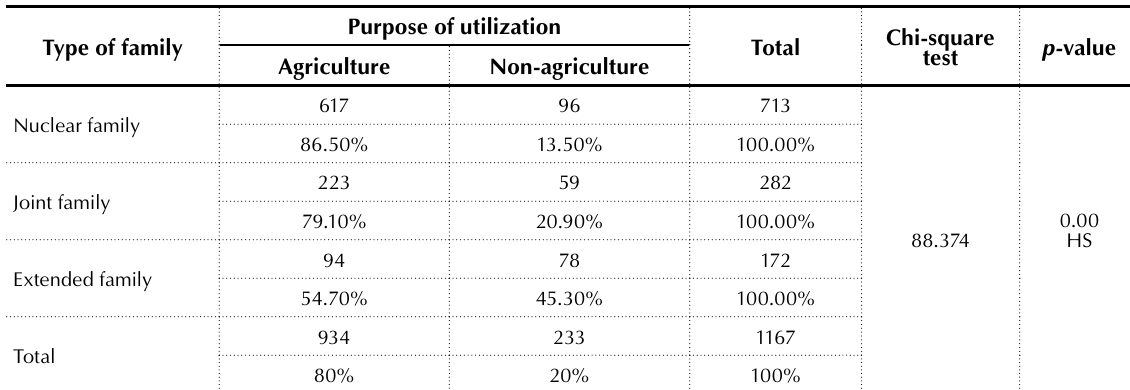
Source: Primary data.